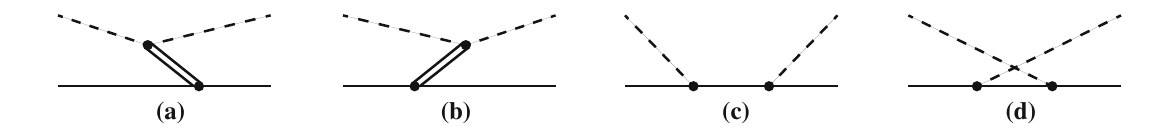
Fig. 1 Time-ordereddiagrams contributingtotheLOmeson–baryon potential.Thedashed, solidanddouble-solid linescorrespond topseudoscalar mesons, octet baryons and vector mesons, respectively Table 1 Coefficients C V of the vector meson M j B j , M i B i exchange contributions in the strangeness S = − 1 sector with